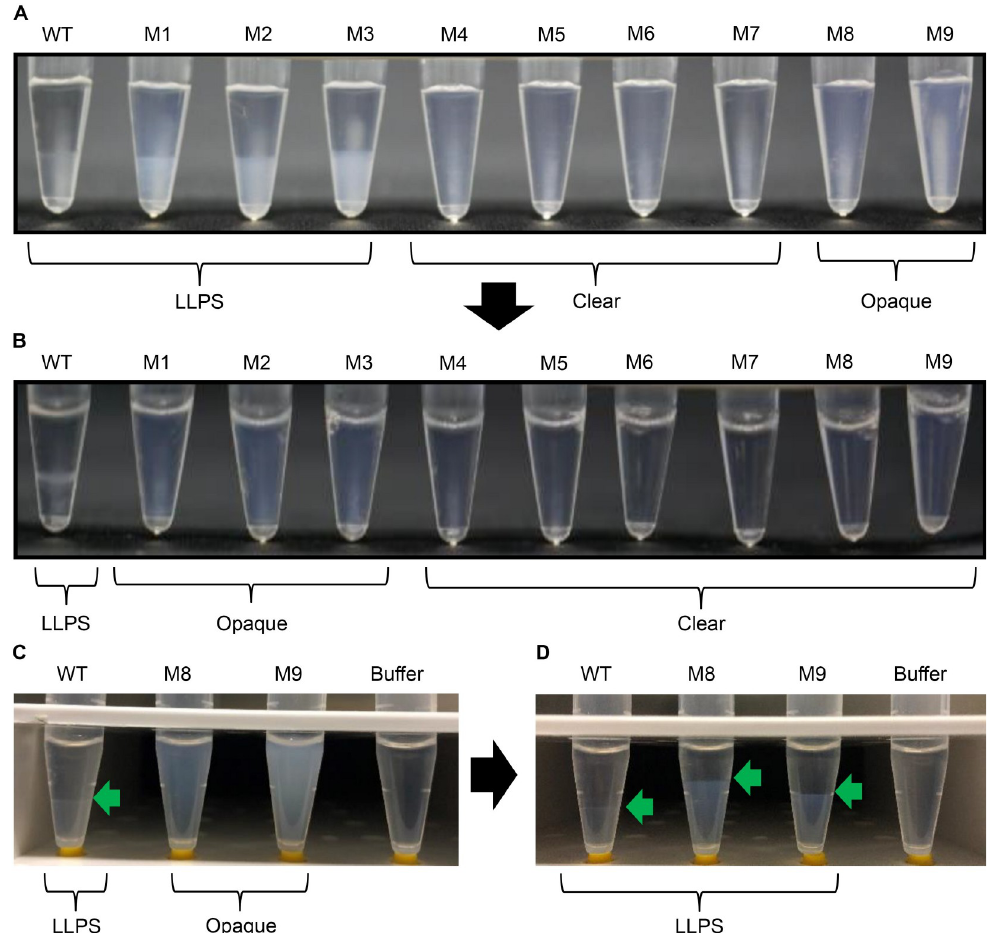
Fig 3. LLPS of WT and mutants at 4˚C. (A) We added 100 μ L of WT and mutant antibodies in 200- μ L PCR tubes and stored them overnight at 4˚C. (B) The samples were then mixed by gentle inversion at 4˚C and stored overnight at